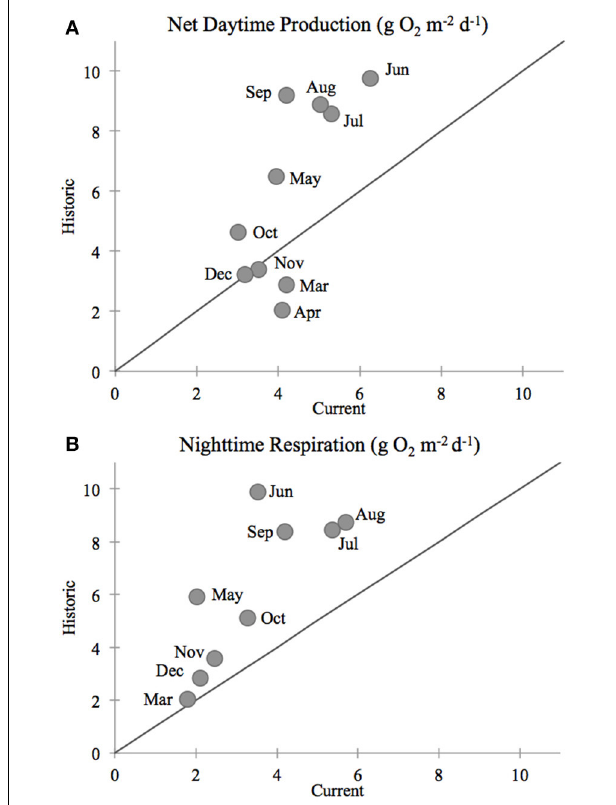
FIGURE 6 | Comparison between Childs River Estuary measurements of (A) daytime net productivity and (B) nighttime respiration rates between the current (2011–2012, this study, WBNERR data) and historic (1991–1992, D’Avanzo et al., 1996) rates. Each data point represents the monthly mean of daily primary production and respiration. The number of days included in those monthly means varies. The number of days included in monthly means was 44 for the current study (2011 and 2012) and 8 for the historic study (1991 and 1992). Monthly averaged daytime production and nighttime respiration values were statistically lower for the current time period compared to the historic (ANOVA p = 0 . 026 and p = 0 . 004, production and respiration means, respectively). Line indicates a 1:1 comparison between the current and historic